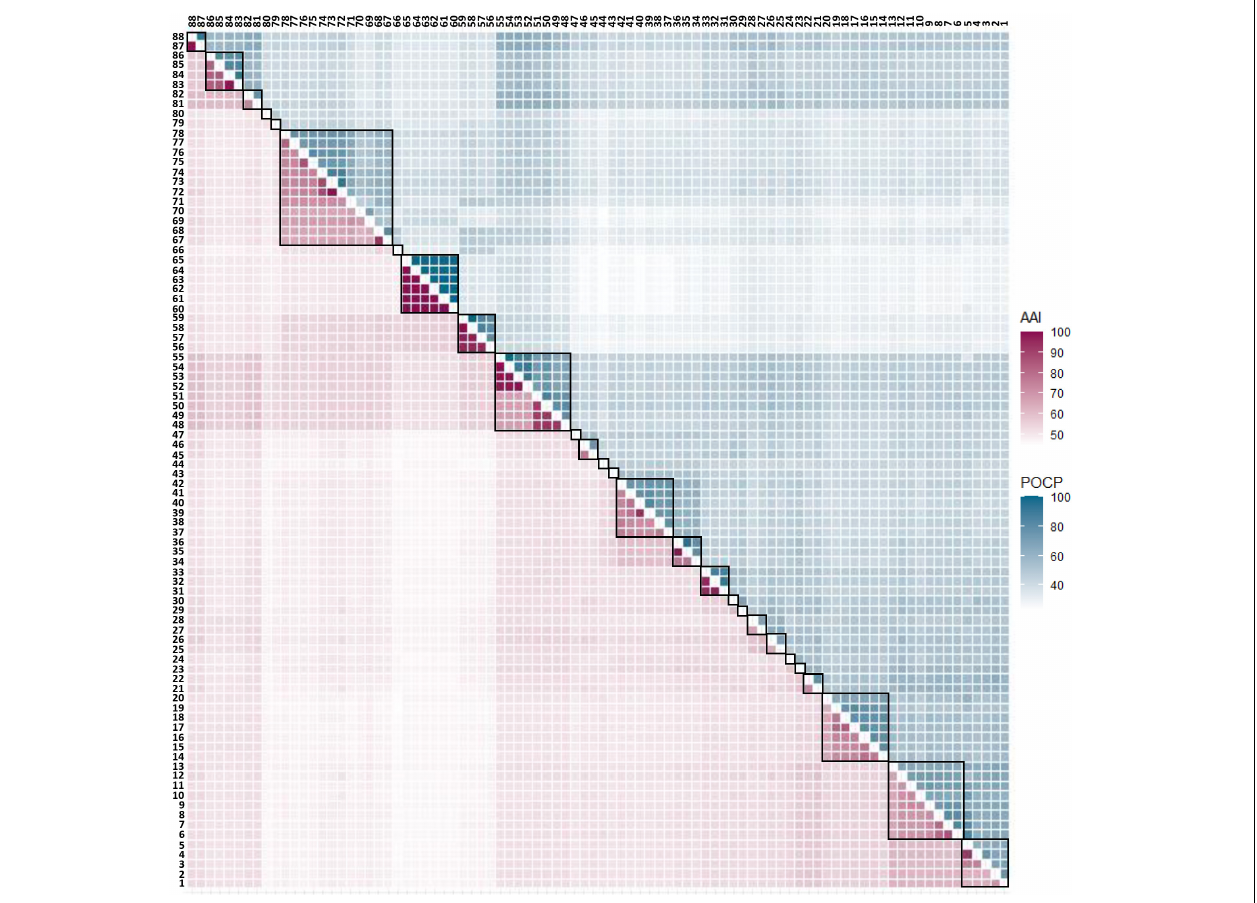
FIGURE 2 | AAI and POCP from pairwise whole-genome comparisons. The values of AAI and POCP were expressed as heatmap. AAI is the lower left triangle indicated in purple color, and POCP is the upper right triangle indicated in cyan color. When the group was divided based on the AAI value alone, it was subdivided into 27 groups, which are separately surrounded by a black square on the